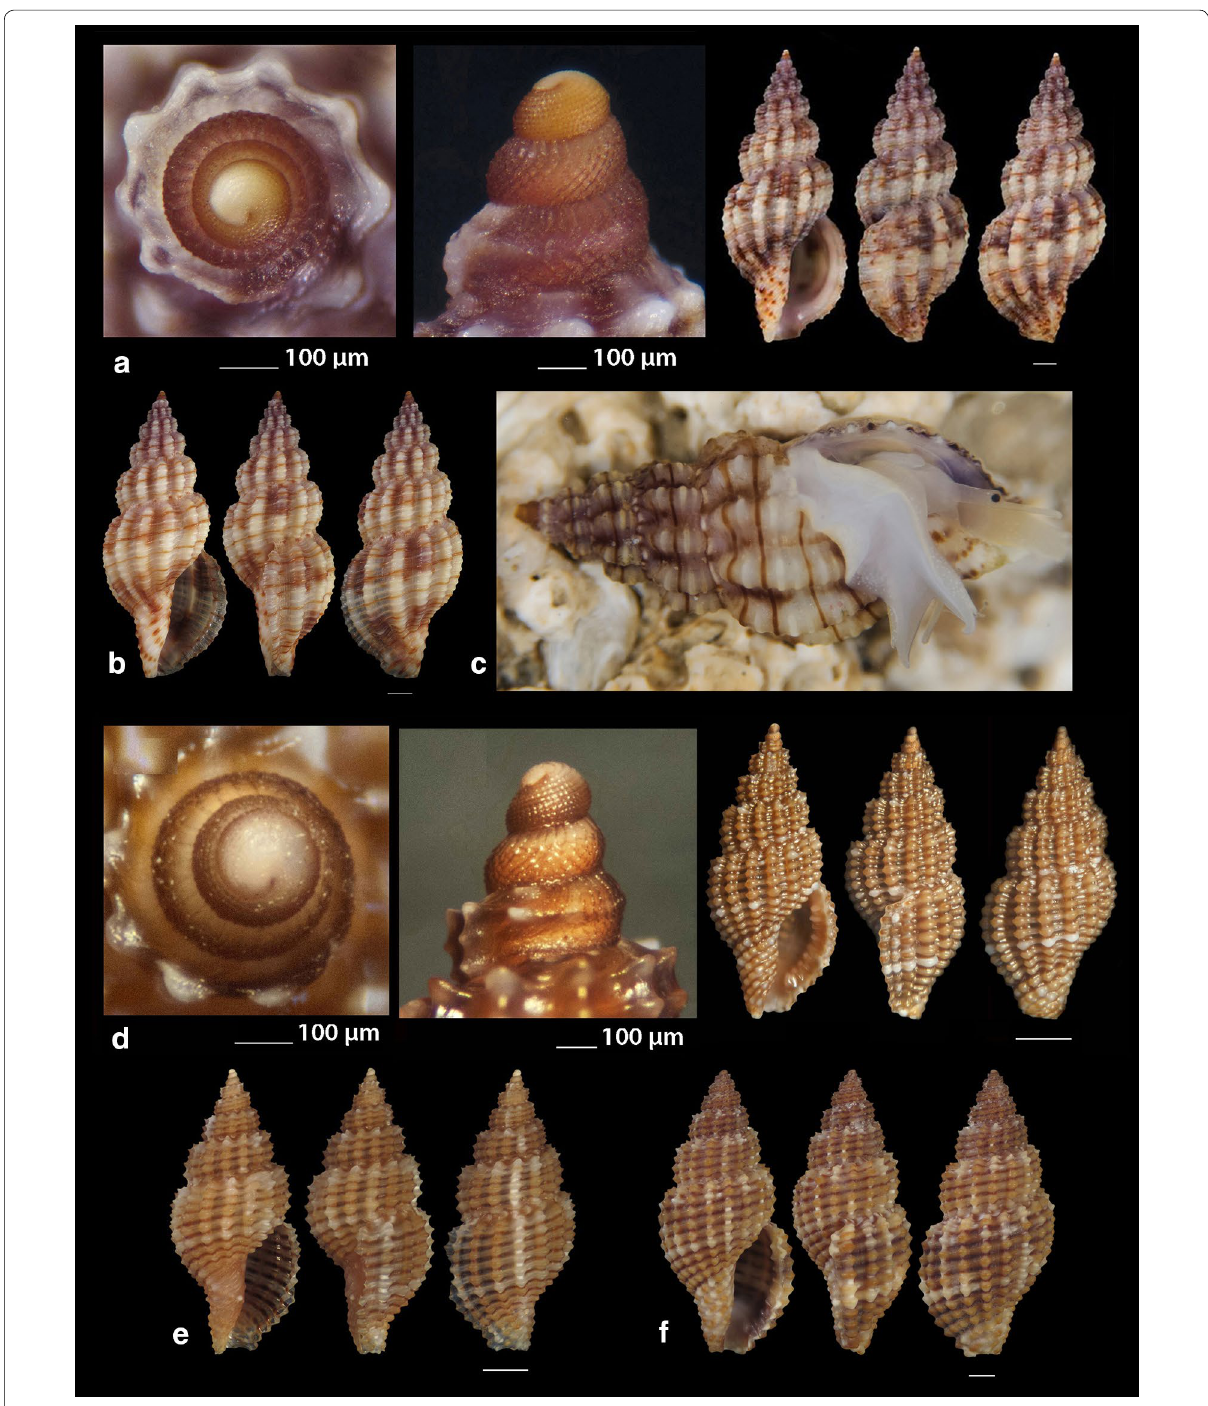
and sigmoid columella angled at its upper part. Anterior siphonal canal strait and slightly elongated and wide, pos- terior one deep and narrow. Outer lip particularly